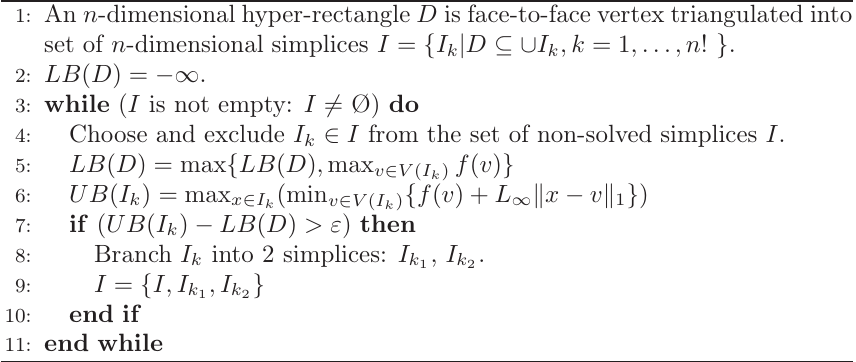
Algorithm 1 Branch and bound algorithm with simplicial